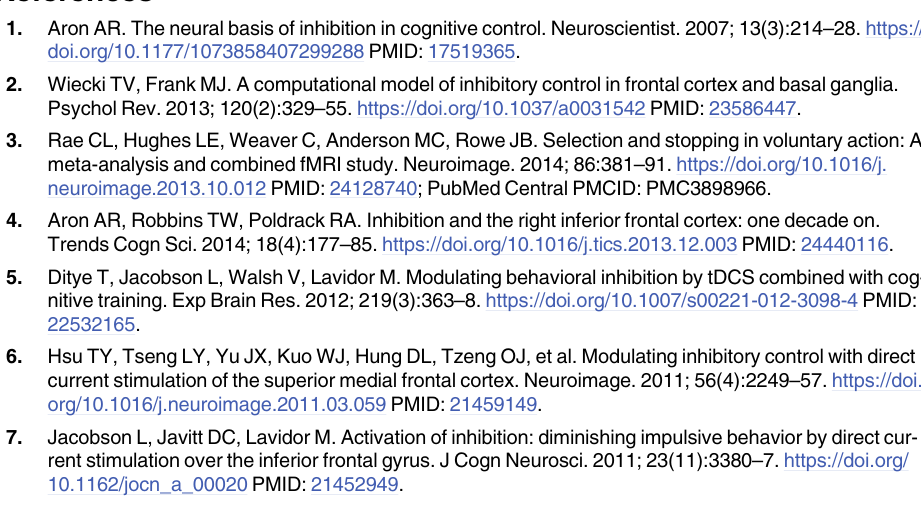
S1 Table. Behavioral results for the Session 1 vs. Session 2 contrast. Response time to Go condition (RT HIT), false alarm rate (FA) and efficiency index in session 1 and session 2. We report the means ± standard deviation, p- and t-values of the comparison (paired t-test) and Cohen’s d effect size. S2 Table. Locations of clusters Local maxima for the functional MRI interaction. Stereo- taxic brain MNI coordinates for peak-voxels of the functional interaction (NoGo-Go)sham > (NoGo-Go)stim. Results are represented at pFWE < 0.05 corrected at voxel level (min cluster size = 3). An asterisk ( (cid:3) ) indicates the anatomical position is retrieved from the nearest GM for this particular peak. Vx = voxel size, Z = Z-score of the